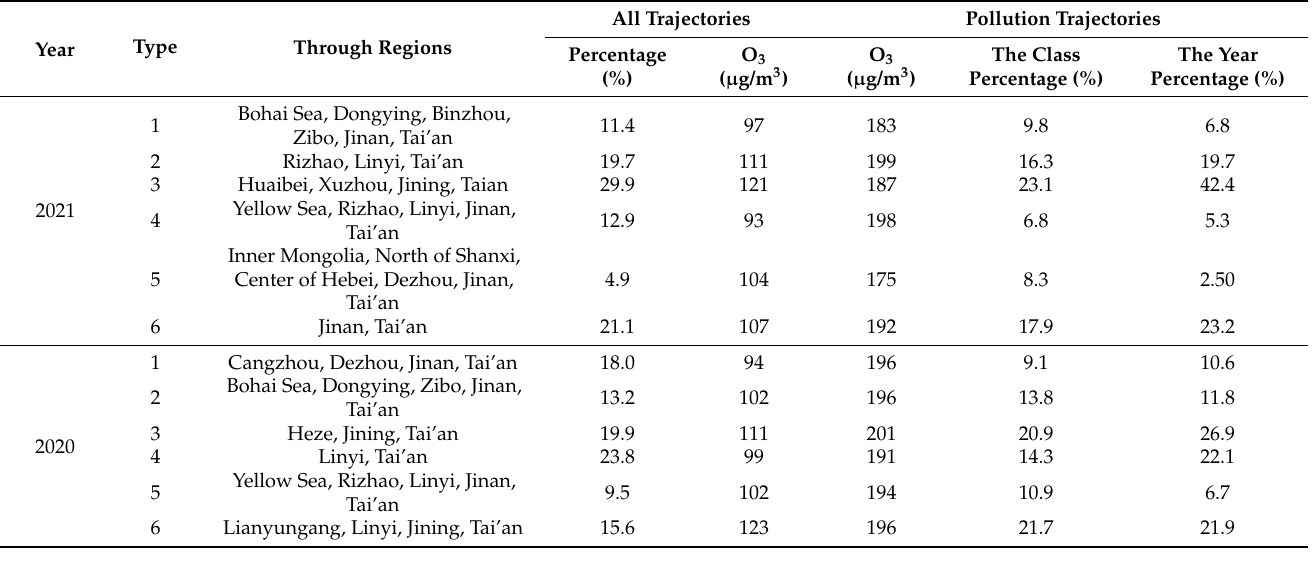
Table 3. Statistics of occurrence frequencies of O 3 trajectories and their corresponding mean O 3 concentrations in Tai’an during May–September in 2020 and 2021.